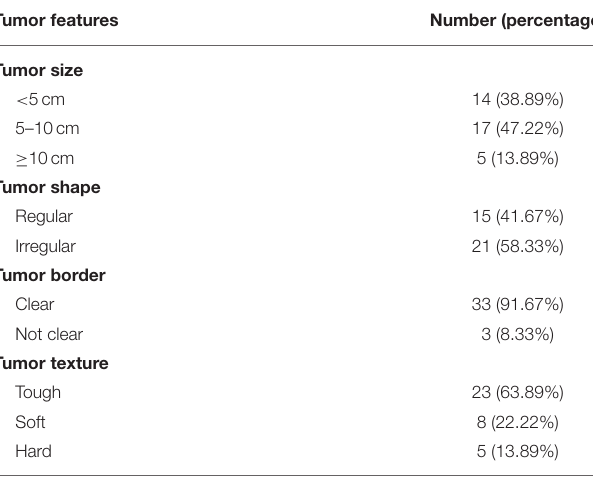
TABLE 2 | Features of 36 retroperitoneal GN tumors.